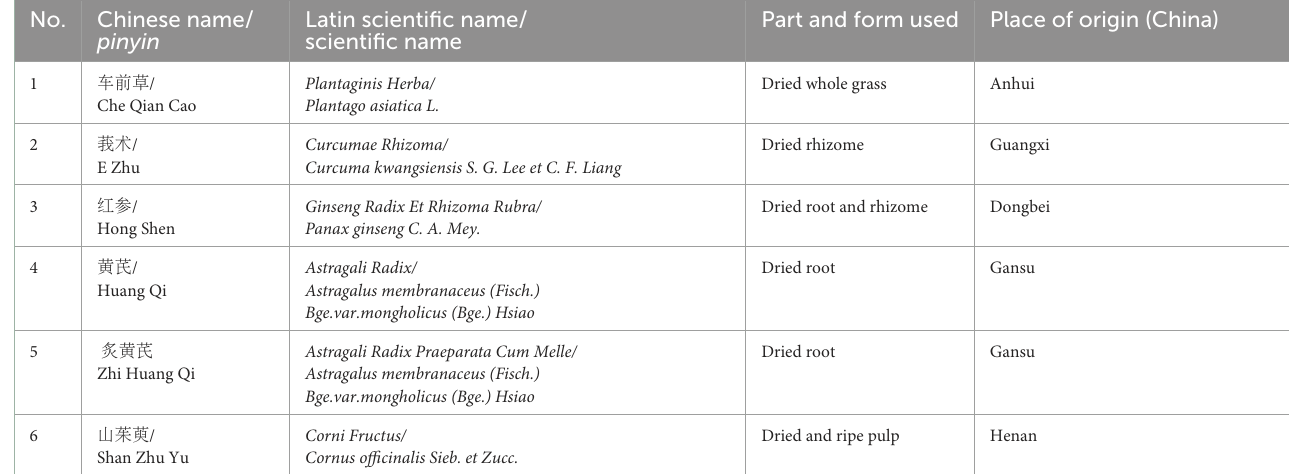
TABLE 1 Components of